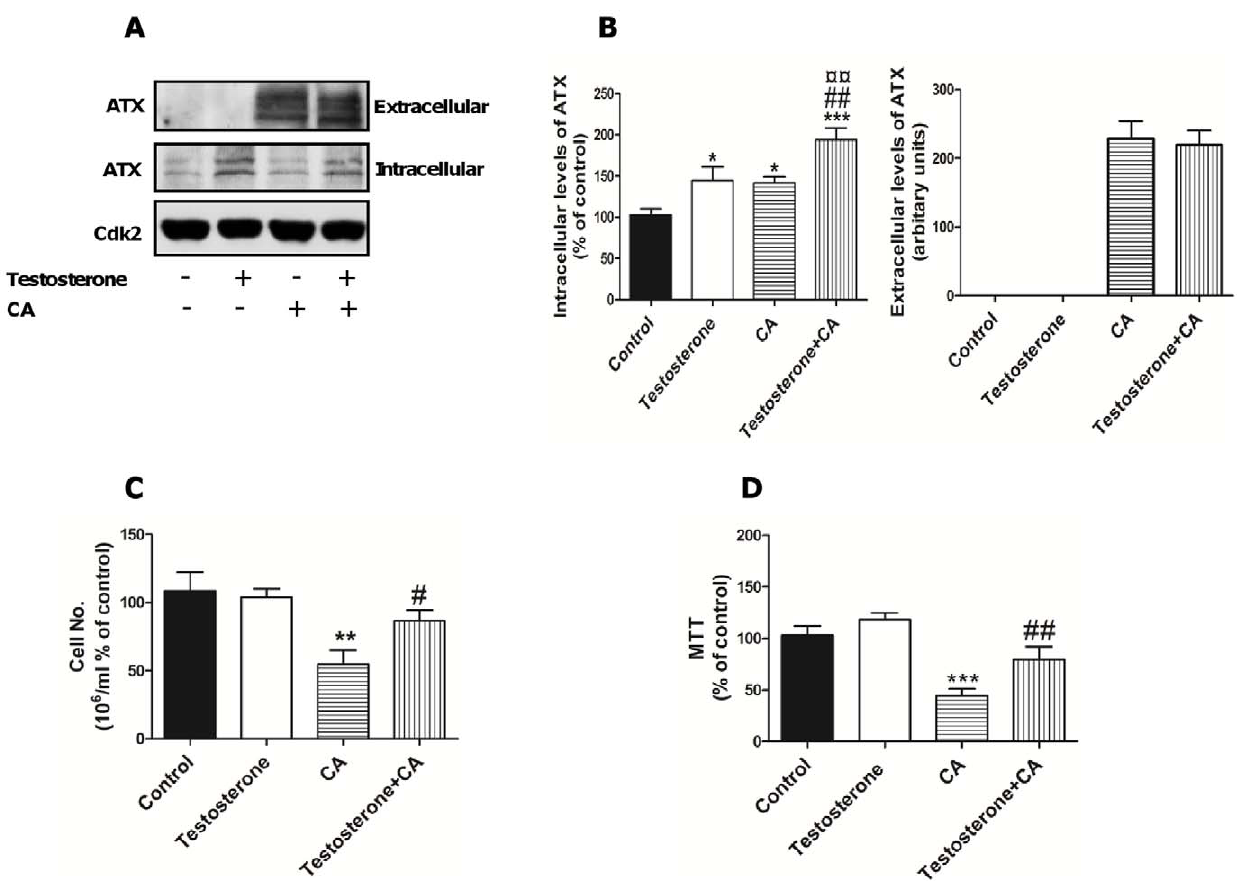
Figure 7. Testosterone increases CA-induced ATX signaling and prevent CA-induced toxicity in Panc-1 cells. Panel ( A ) and ( B ) show Western blots and densitometric analysis of extracellular and intracellular ATX levels. Cells were incubated with 1 nM testosterone for 24 hours and thereafter with 10 m M CA for additional 24 hours. ( C ) Cells were stained by trypan blue and counted under light microscope. Cells were preincubated with 1 nM testosterone for 24 hours and thereafter treated with 10 m M CA for additional 24 hours. ( D ) Cell numbers measured by MTT. Cells were preincubated with 1 nM testosterone for 24 hours and thereafter treated with 100 m M CA for additional 24 hours. Data was obtained from three independent experiments. Results are presented as mean 6 SD. *significantly different from controls (*p , 0.05, **p , 0.01, ***p , 0.001). # significantly different from CA alone ( # p , 0.05, ## p , 0.01). ¤significantly different from testosterone alone (¤¤p , 0.01).